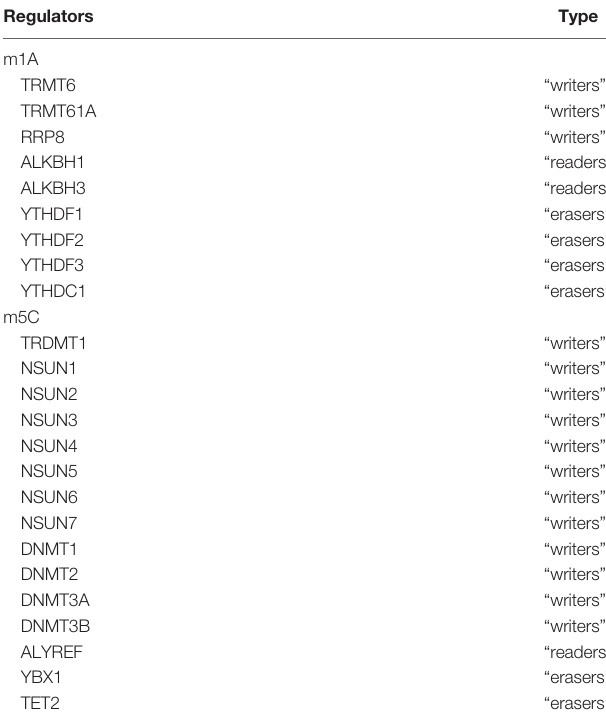
TABLE 2 | The list of the RNA modifying proteins involve in m1A, m5C.